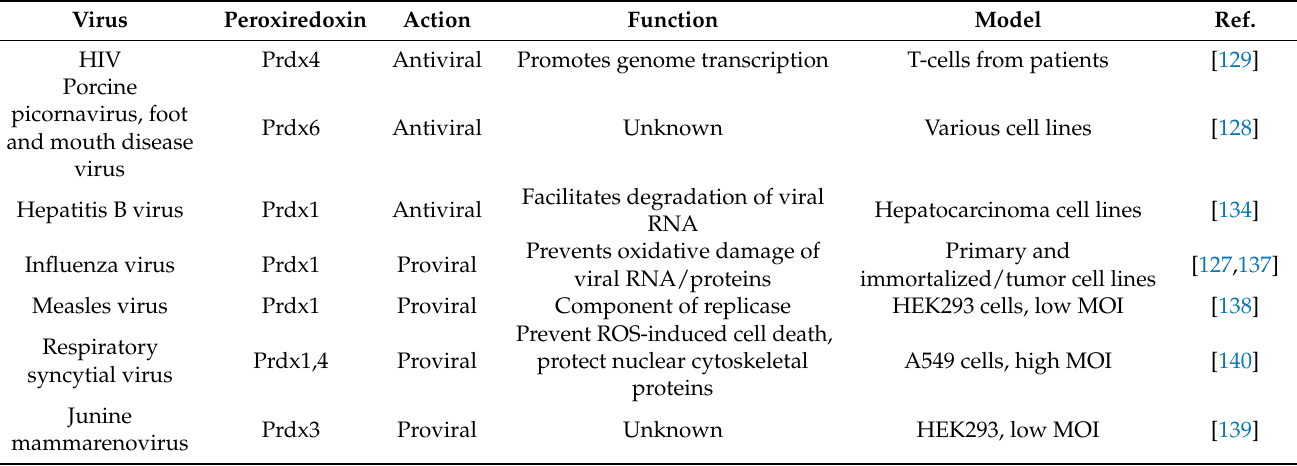
Table 3. Effect of peroxiredoxins on replication of